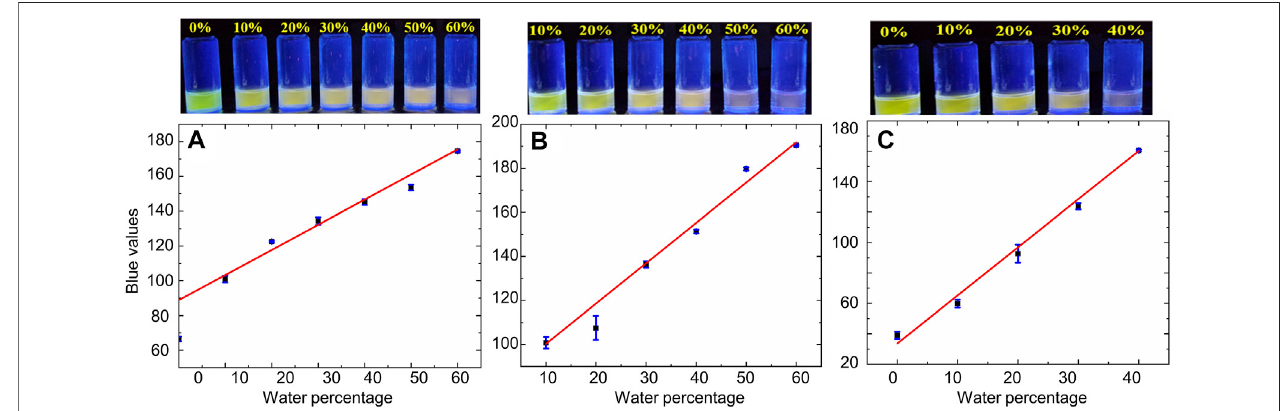
FIGURE 4 | Top: Naked eye color changes induced by the addition of increasing percentages of water to water-miscible solvents. Bottom: The linear relationship between the added water percentage and the quantitative blue value of the solution, measured from photographs taken under 365 nm excitation. (A) Acetonitrile solutions; (B) DMF solutions; and (C) DMSO solutions (other solvents are shown in the ESI; blue bars represent the calculated standard deviations for each data point).